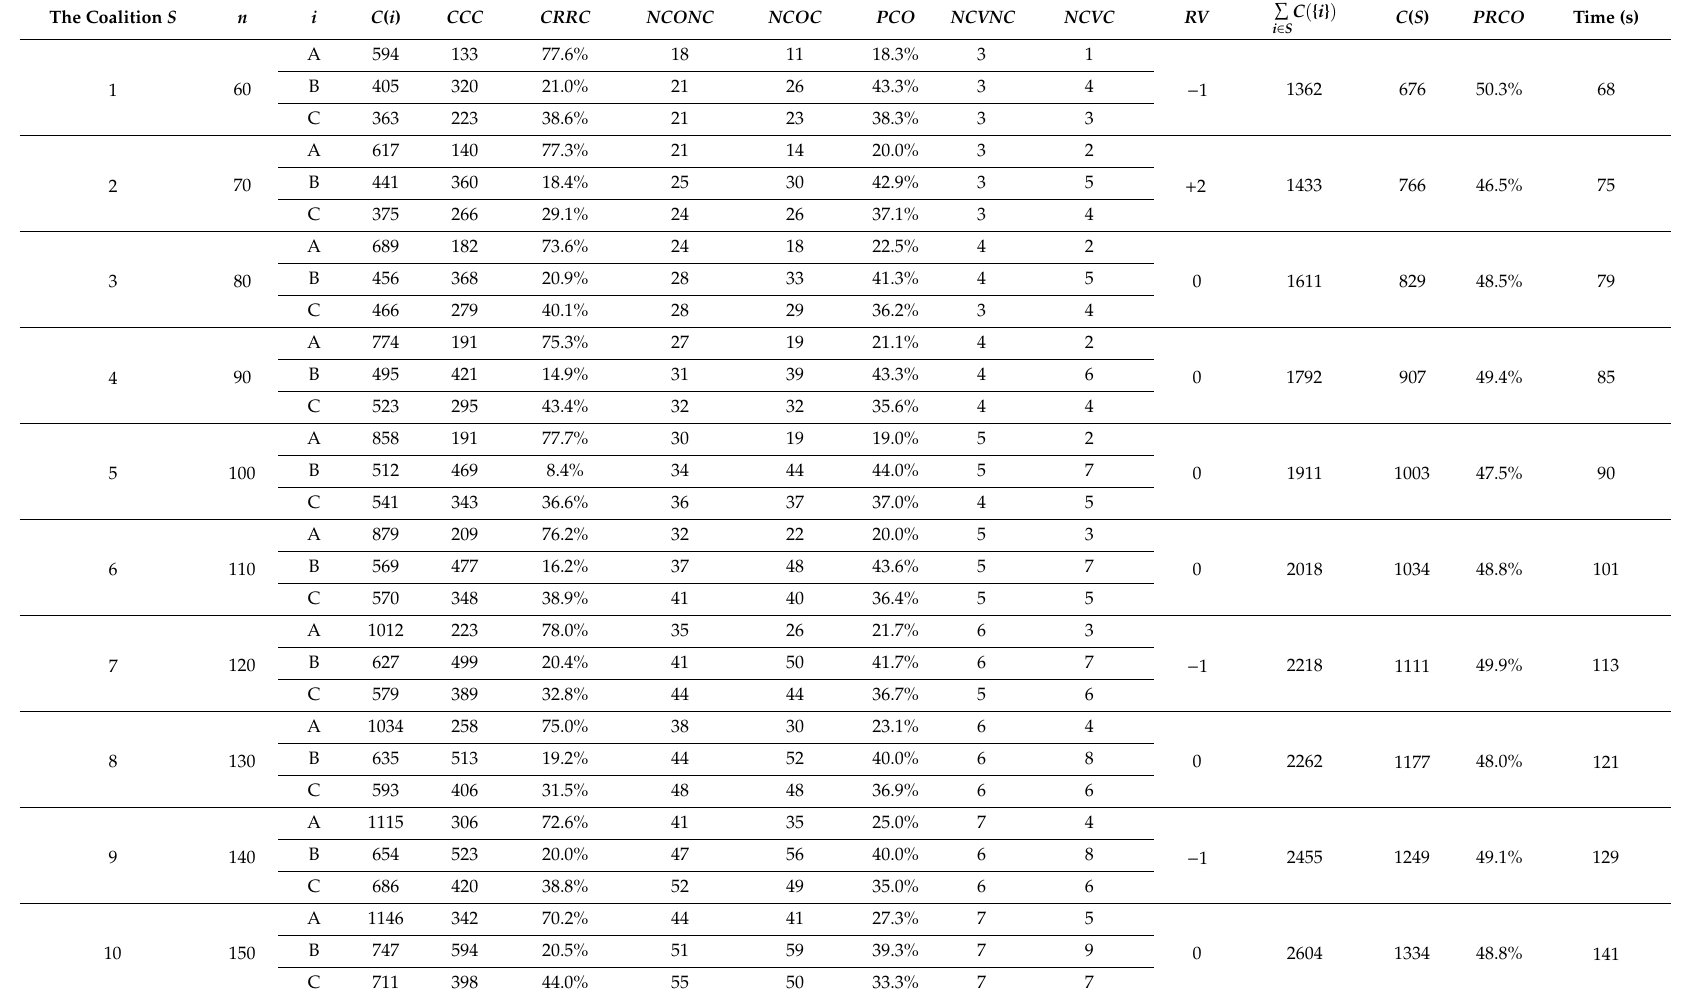
Table 5. The results of transportation